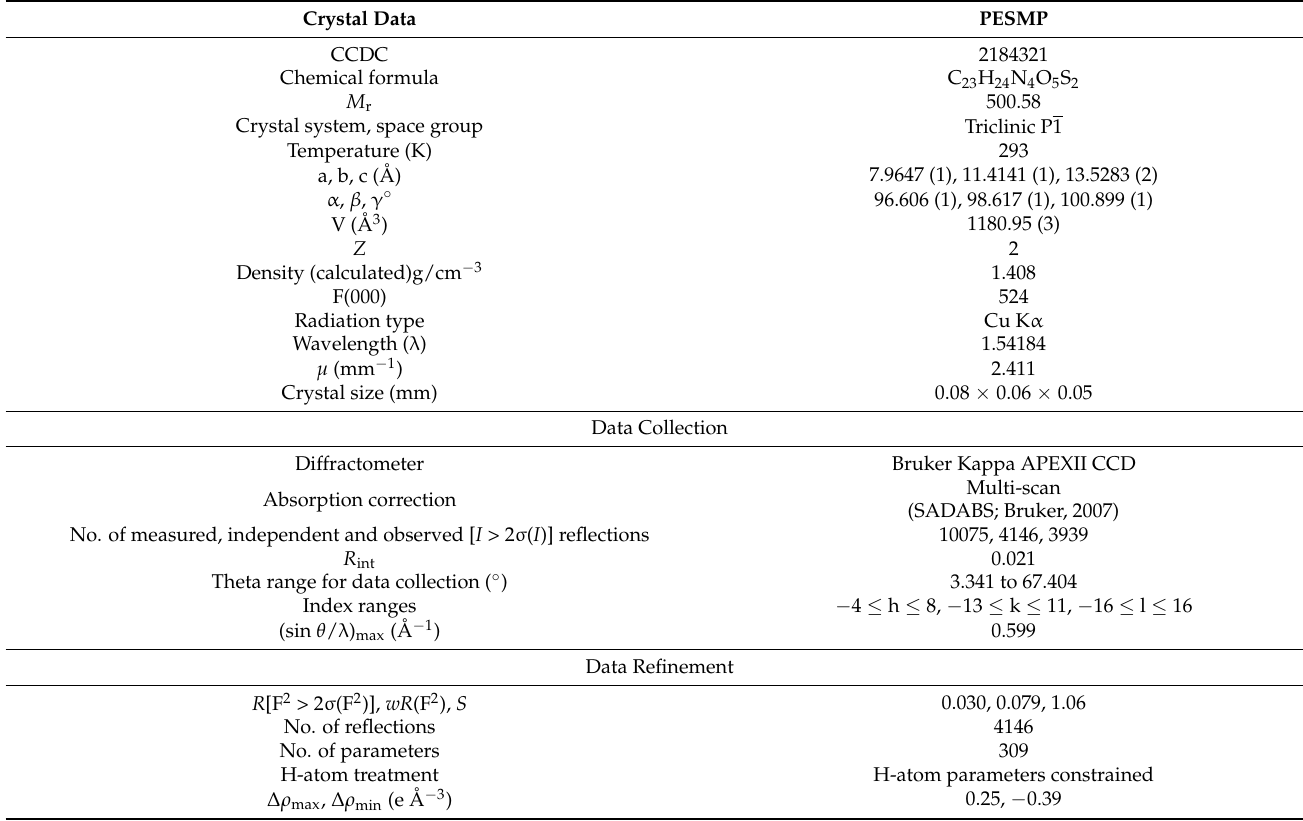
Figure 2. ORTEP presentation of PESMP which is visualized at a 50% level of probability. Hydrogen atoms are displayed by small circles with arbitrary radii. Table 1. Single-crystal X-ray diffraction data of PESMP compound.